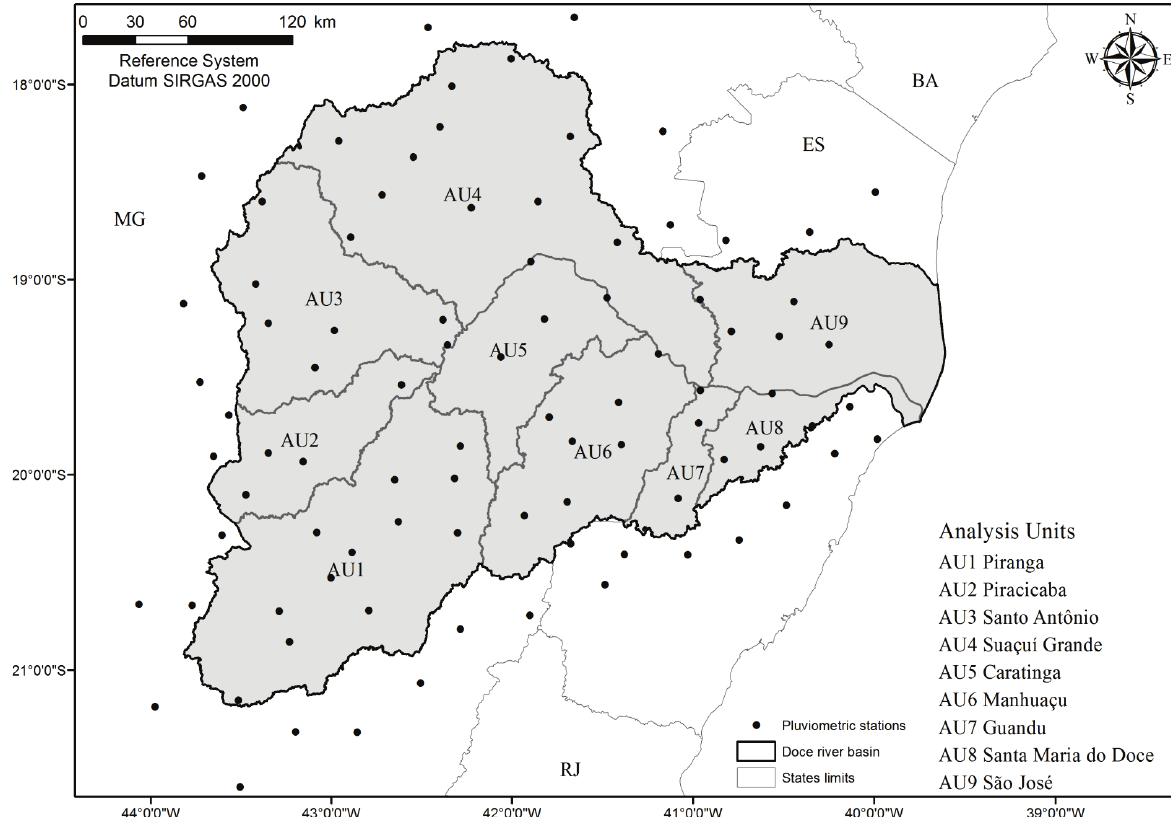
Figure 1 - Analysis units (AUs) and pluviometric stations of the ANA hydrometeorological network selected for the study in the Doce river